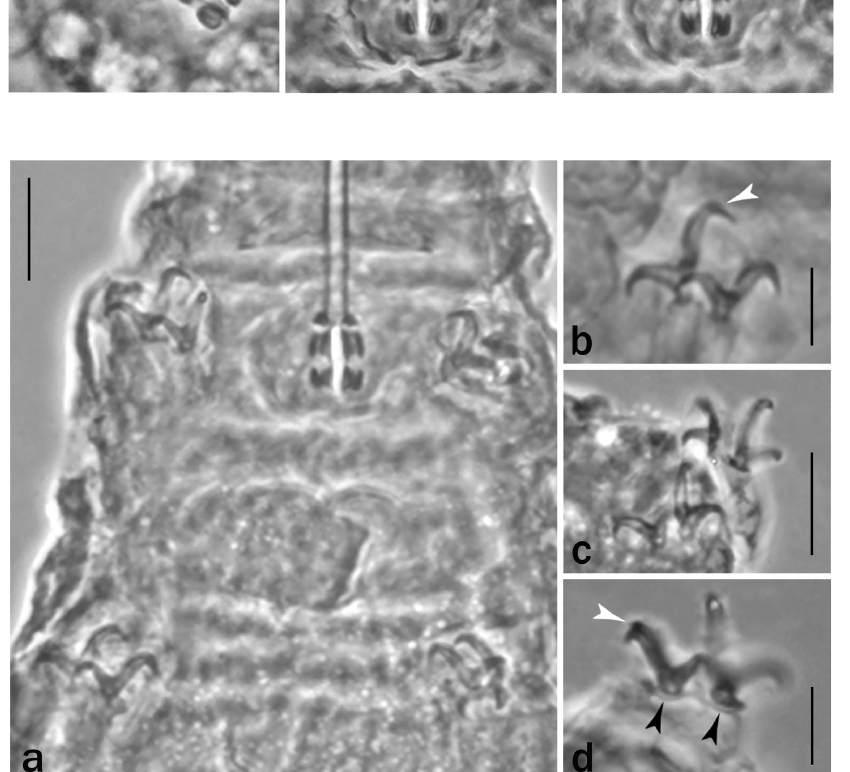
Figure 3. Bucco-pharyngeal apparatus of Mixibius gibbosus sp. nov. (a) general view of the holotype (slide No. 00613-4). (b) general view of a paratype (slide No. 00613-8); the black arrow indicates the central constriction of the first macroplacoid. (c) lateral view of a paratype (slide No. 00546- 4) showing the apophyses for the insertion of the stylet muscles (AISM) typical of the genus: dorsal (black arrowhead), ventral (black arrow), posterior thickenings (white arrowheads). (d) dorsal focal plane showing the relative AISM of the holotype (arrowhead). (e) ventral focal plane showing the relative AISM of the holotype (arrow). Scale bars are all 10